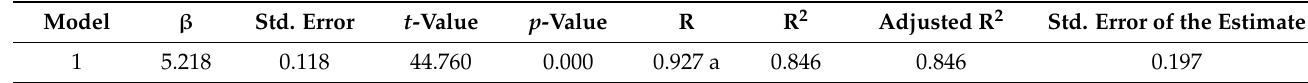
Table 2. Summary of regression analysis conducted.